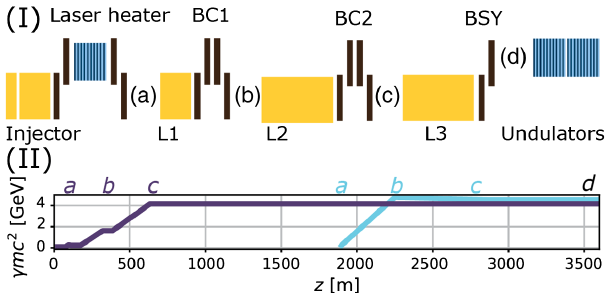
FIG. 4. (I) Cartoon of LCLS-II beamlines (not to scale). “ L ” stands for linac, “ BC ” for bunch compressor, and “ BSY ” for beam switch-yard. The BSY is a sequence of doglegs which nominally have R 56 ¼ 0 but may be adjusted to allow lower energy particles to move toward the head of the bunch. (II) Central energy along the superconducting (purple) and copper (light blue) beamlines, illustrating the vast differences in space charge impedance in the two